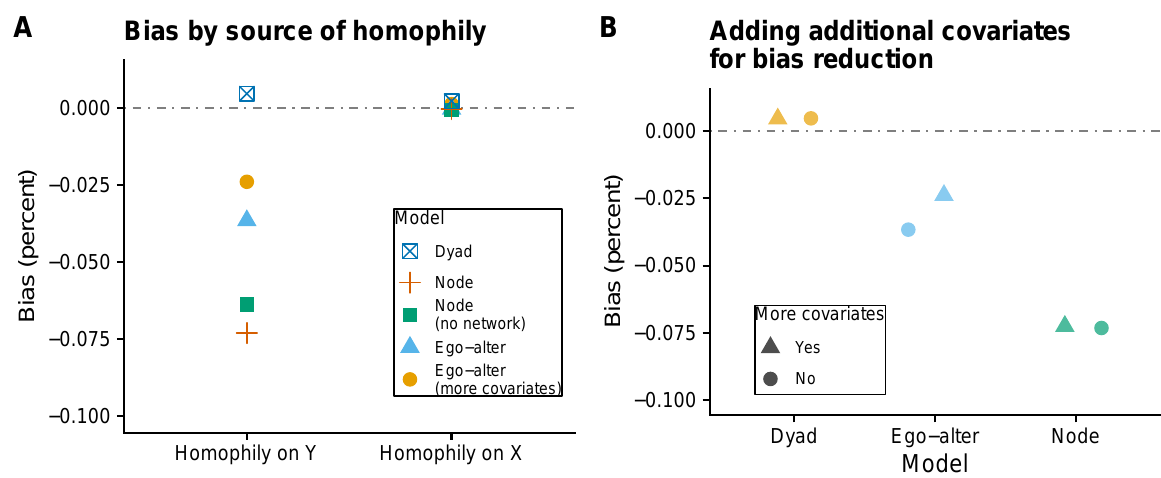
Figure 7: ( A ) shows that the source of homophily determines the level of bias when using a model-based approach. When homophily happens directly on the Y variable (egos choose alters based on Y ) and the X variable does not fully capture the variation in Y associated with homophily, bias occurs unless an edge model is used. However, when homophily happens based on the X variable (egos choose alters based on X ), no such bias occurs for any of the models examined. Note that the overall level of homophily in the graph is equal for these two cases. ( B ) demonstrates that different modeling strategies respond differently to the inclusion of additional network information (here, log degree). The ego–alter modeling strategy benefits from this additional information. Bias is displayed here, but the pattern is similar for absolute error: the ego–alter model shows gains from additional information where node and edge models do not. These plots show edge sampling, but results are similar for node and proportional-to-degree